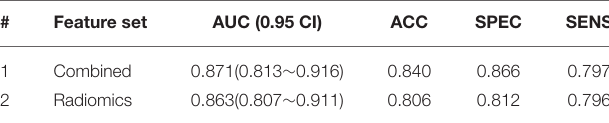
TABLE 5 | Performance comparation between two